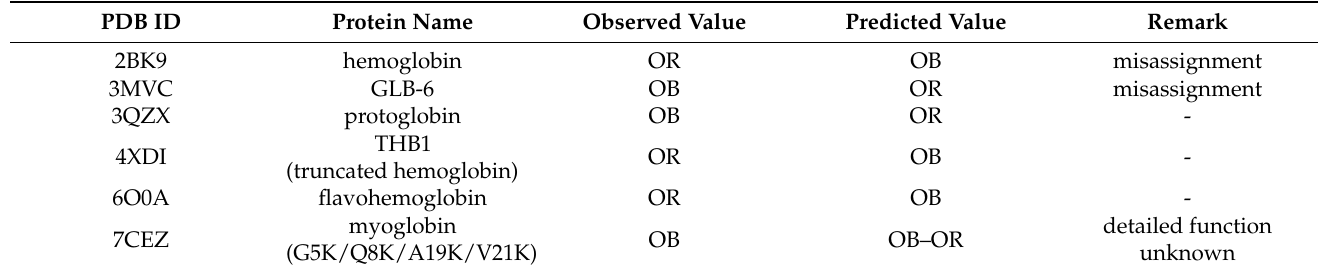
Table 3. List of the samples that failed to predict other than those classified as OB and